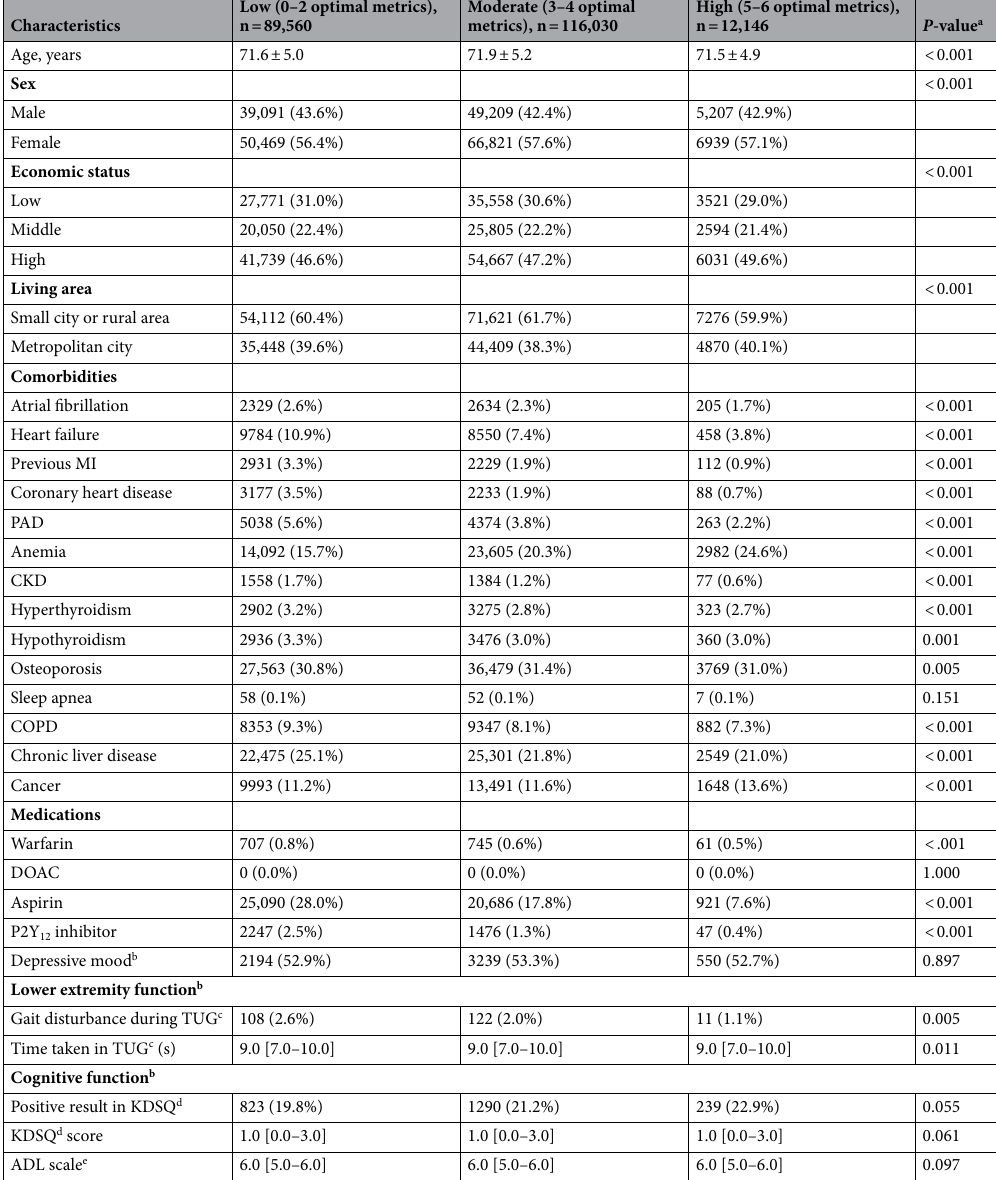
Table 1. Baseline characteristics according to baseline CVH Status. Continuous variables are presented as mean ± standard deviation for normally distributed data or median [interquartile range] for non-normally distributed data, and categorical variables are presented as number (percentage). a P-values for the contrast between three groups were derived from Pearson’s Chi-square for categorical variables and one-way analysis of variance or Kruskal–Wallis test for continuous variables where appropriate. b Three additional tests, conducted on some of the study participants (n = 11,273) who underwent additional cognitive screening during the life transition period. c TUG test measures the time that a person takes to rise from a chair, walk 3 m, turn around, walk back to the chair, and sit down. The more time taken indicates poorer physical function and balance. d The KDSQ includes five items. Each item on the KDSQ is scored from 0 to 2, with a higher score indicating poorer function and a greater frequency. A KDSQ score ≥ 4 indicates a positive result. e The ADL scale is a measurement of routine activities people do every day without assistance, which includes eating, bathing, getting dressed, and toileting, as well as mobility and continence. Higher scores indicate better and independent physical performance. ADL activities of daily living, CKD chronic kidney disease, COPD chronic obstructive pulmonary disease, CVH cardiovascular health, DOAC direct oral anticoagulant, KDSQ Korean Dementia Screening Questionnaire, MI myocardial infarction, PAD peripheral artery disease, TUG timed up and go